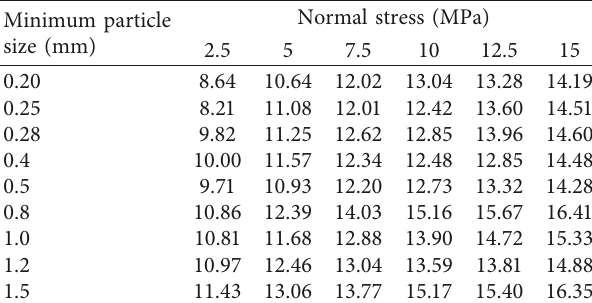
Figure 8: Influence of parallel bond elastic modulus on cohesion. Table 5: Shear strength of different particle size specimens under normal stress.